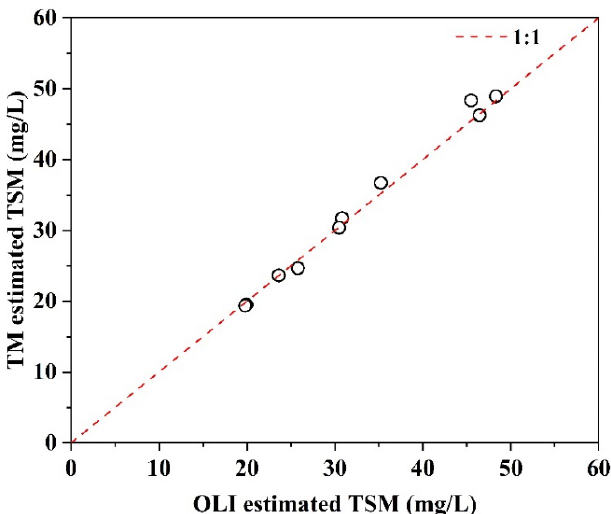
Figure 5. Comparing OLI-estimated TSM and TM-estimated TSM based on the validation data.